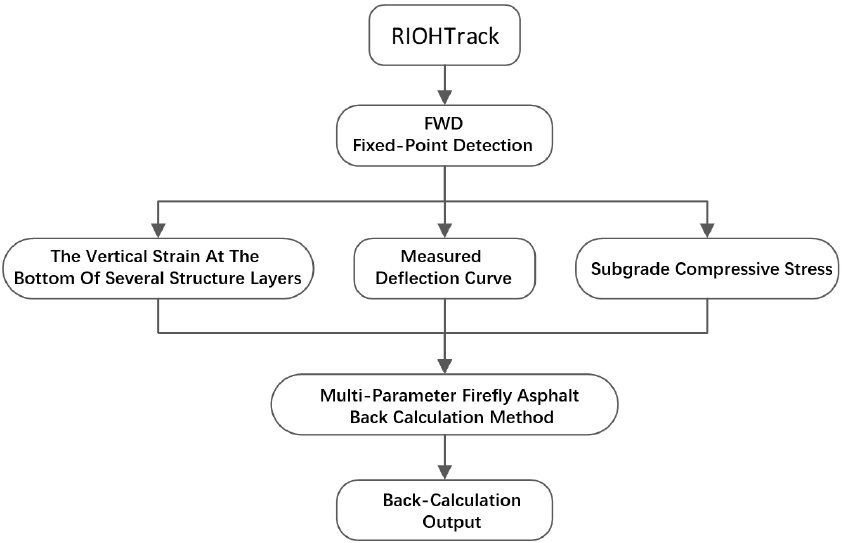
Figure 3. The multi-parameter FABCM process.